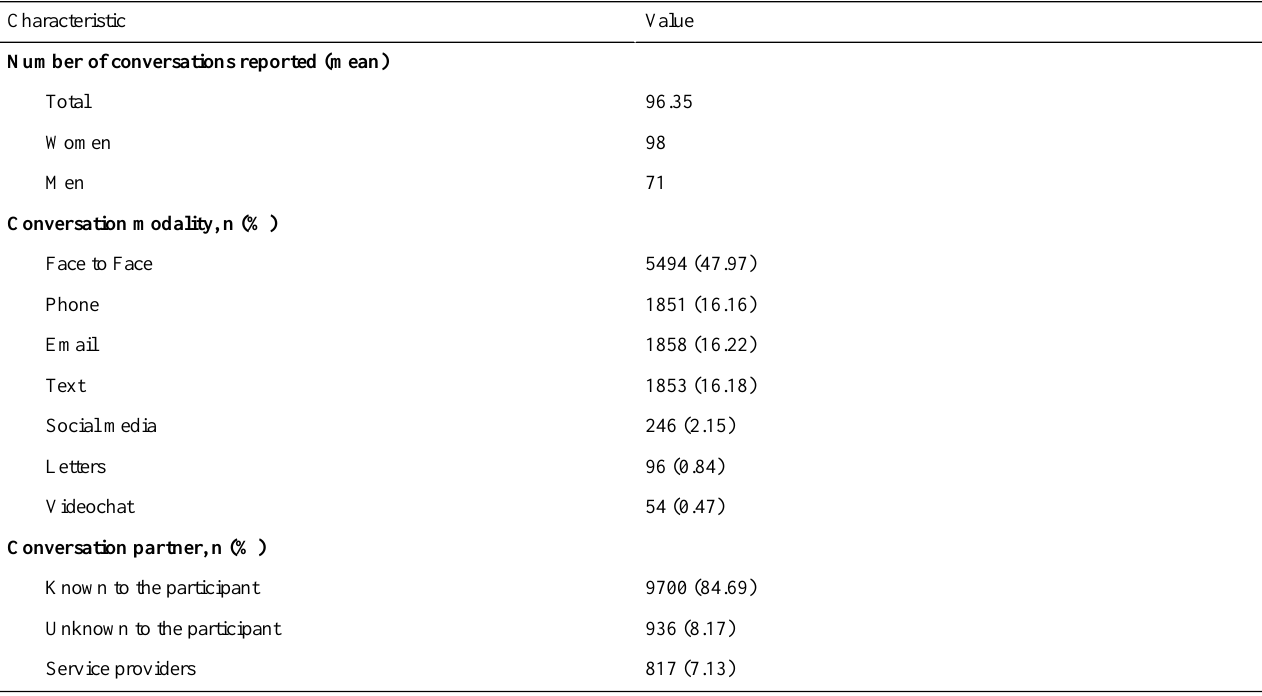
Table 1. Descriptive characteristics of the reported conversations